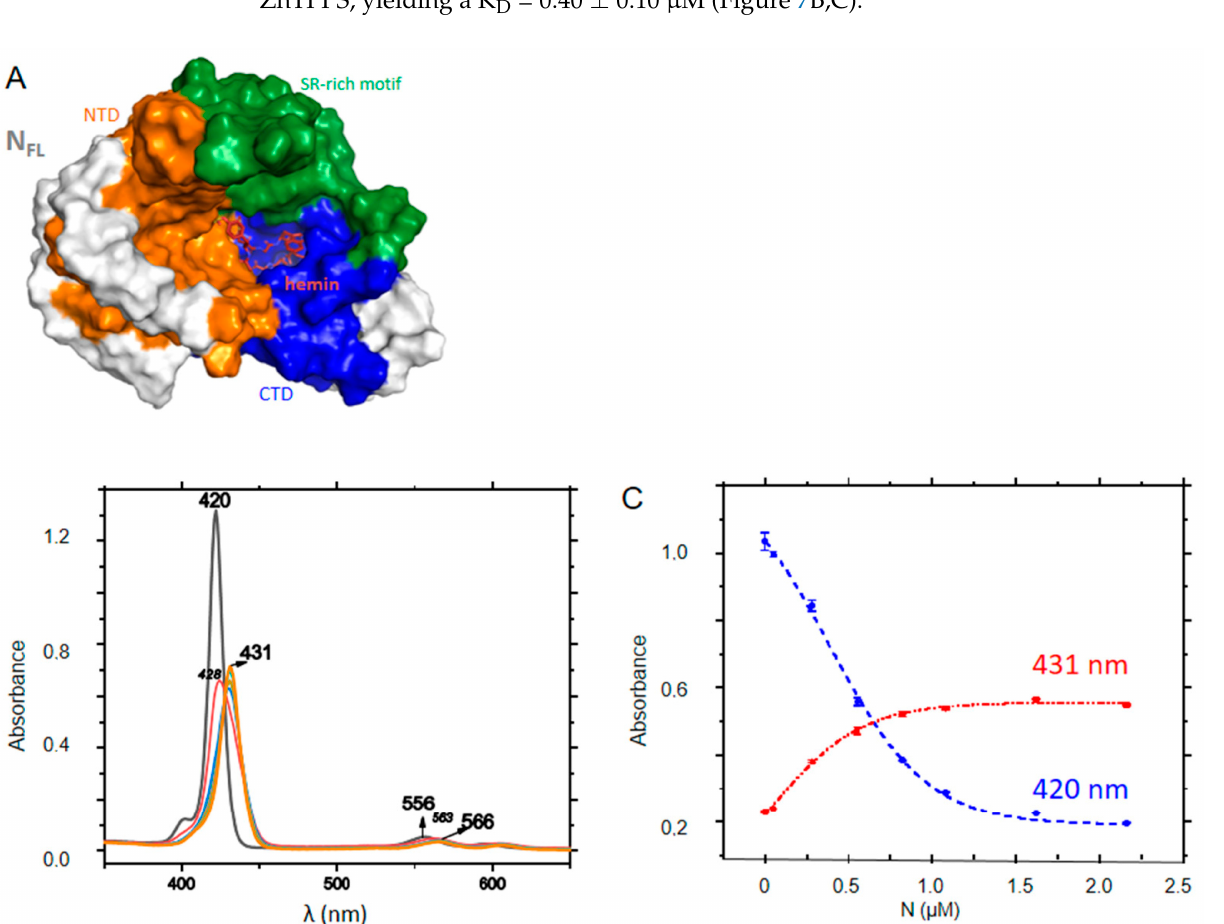
Figure 7. Interactions of FL with ZnTPPS. ( A ) the porphyrin shown in red binds at the C-terminal cavity of FL (See also Table 2). ( B ) Absorption changes of ZnTPPS upon titration with FL; ( C ) Absorbance at Soret maxima of the free (420 nm) or FL-bound (431 nm) porphyrin; the dashed lines correspond to fits of the experimental data according to a dose-response function, yielding K D = 0.40 ± 0.10 µ